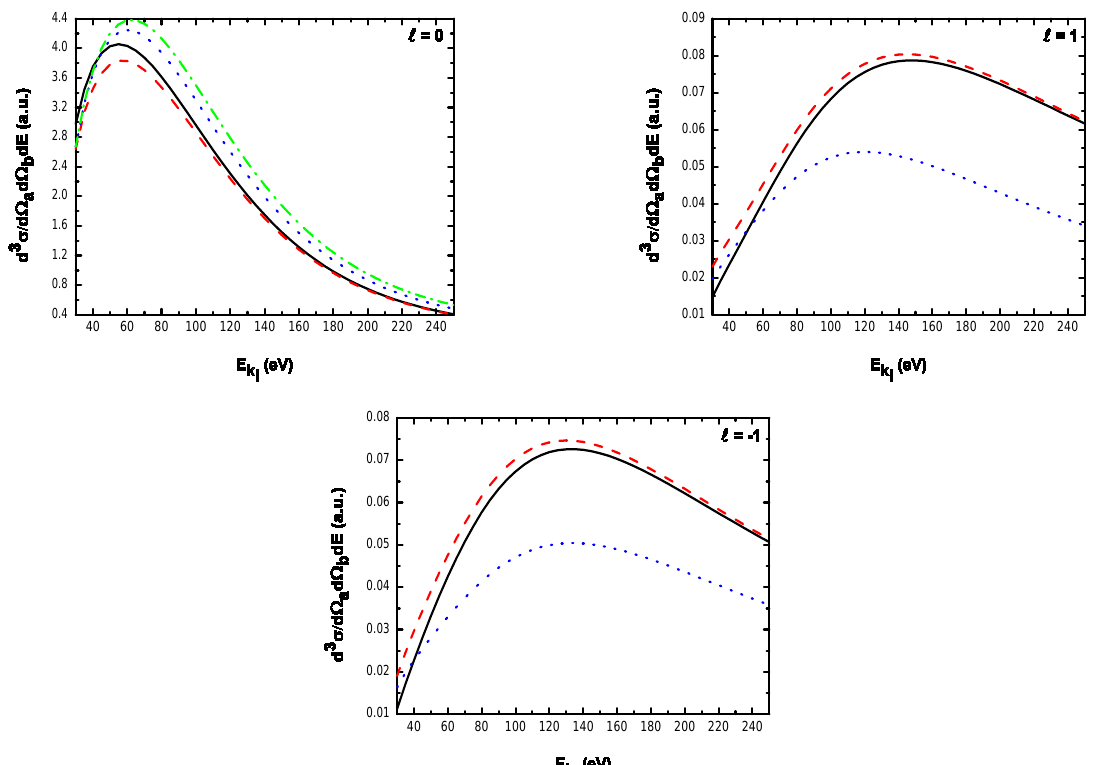
Figure 11. Triple differential cross sections corresponding to the laser-assisted electron-impact ionization process of atomic hydrogen as a function of the incident electron energy E k frequency is 1.17 eV, the electric field strength is E 0 = 1 × 10 7 V/cm. The ejected electron energy is = 5 eV, the scattering angle is θ a = 5 ◦ , and the emission angle of the ejected electron is θ E k b The laser polarization of the field is set parallel to the incident momentum ( ˆ ε // k i ) . : second Born approximation results. − − − : first Born approximation results. · · · · · : results obtained by neglecting the dressing of the target. − · − · − : field-free